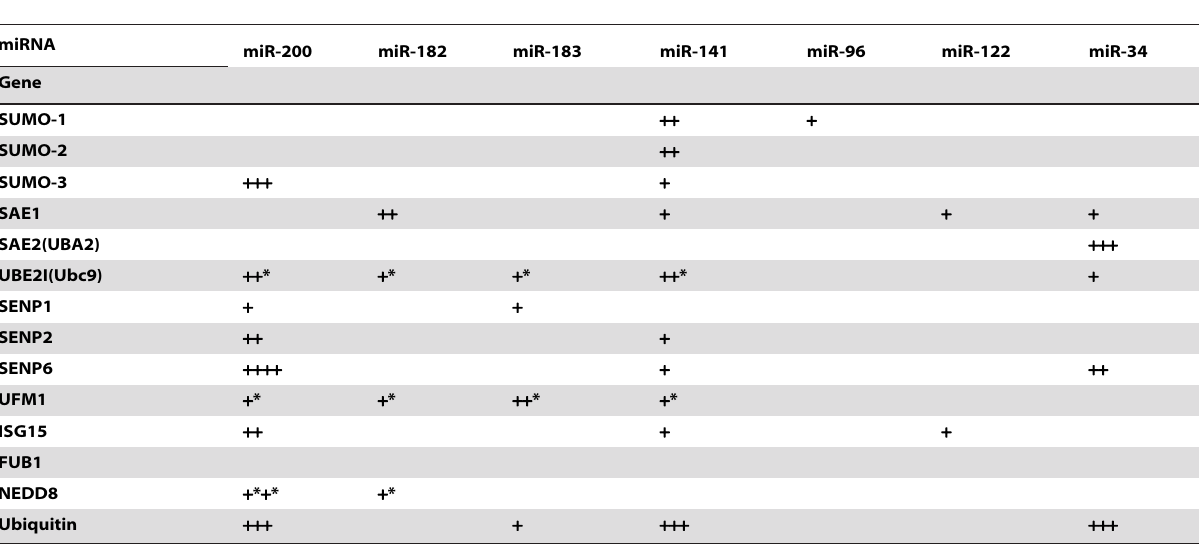
Table 2. Number of potential target sites of miRNAs of interest in SUMO-related genes and other ULMs.